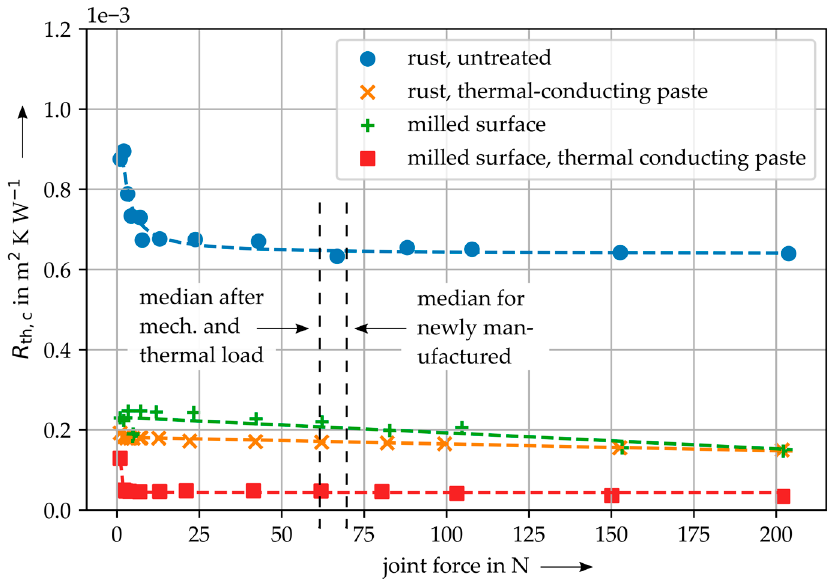
Figure 14. Specific thermal contact resistances for heating rod and rail with a length of 35 mm dependent on the joint force for different surface conditions (untreated or milled and with or without thermal-conducting paste ϑ = 0.5 K W − 1 ).